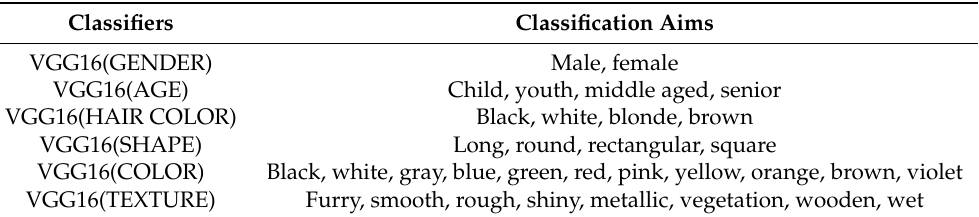
Table 4. Attribute predictors with different